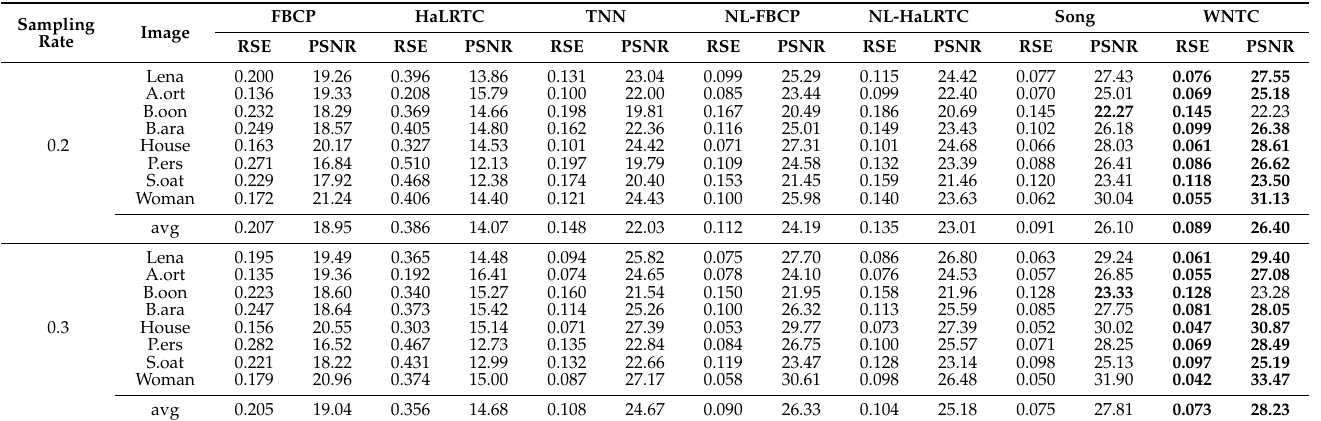
Figure 3. Eight color RGB pictures. Table 1. PSNR and RSE results of different image recovery algorithm.